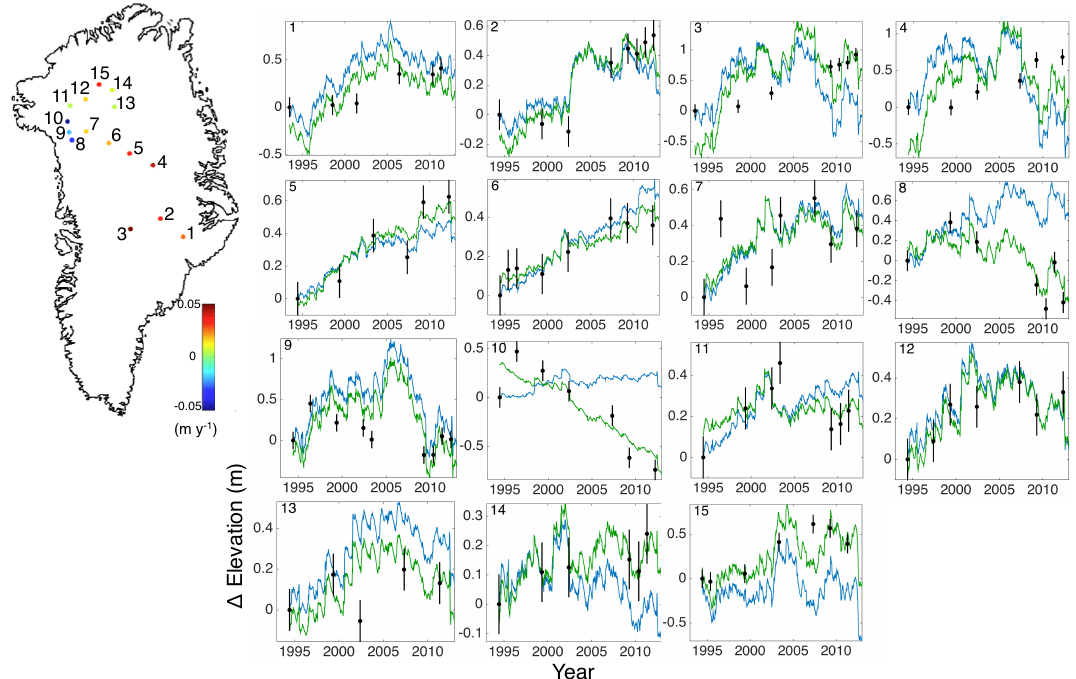
Figure 5. Upper left panel: map of elevation change points observed by the airborne laser altimeter ATM, with colour scale giving the 20-year trend in elevation (myr − 1 ). The 15 panels (numbers in the upper left corner of each panel correspond to the numbered locations on the map) show surface elevation change from (black dots with 1 σ error bars) ATM lidar and (blue curves) firn thickness model. Green curves are the firn model results adjusted to the trend in residuals between the model and the